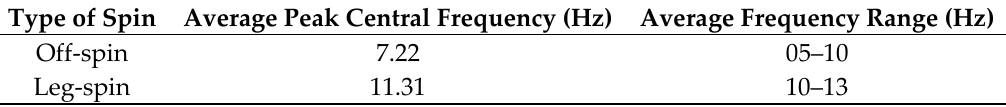
Table 1. Comparison between off-spin and leg-spin in the frequency domain.